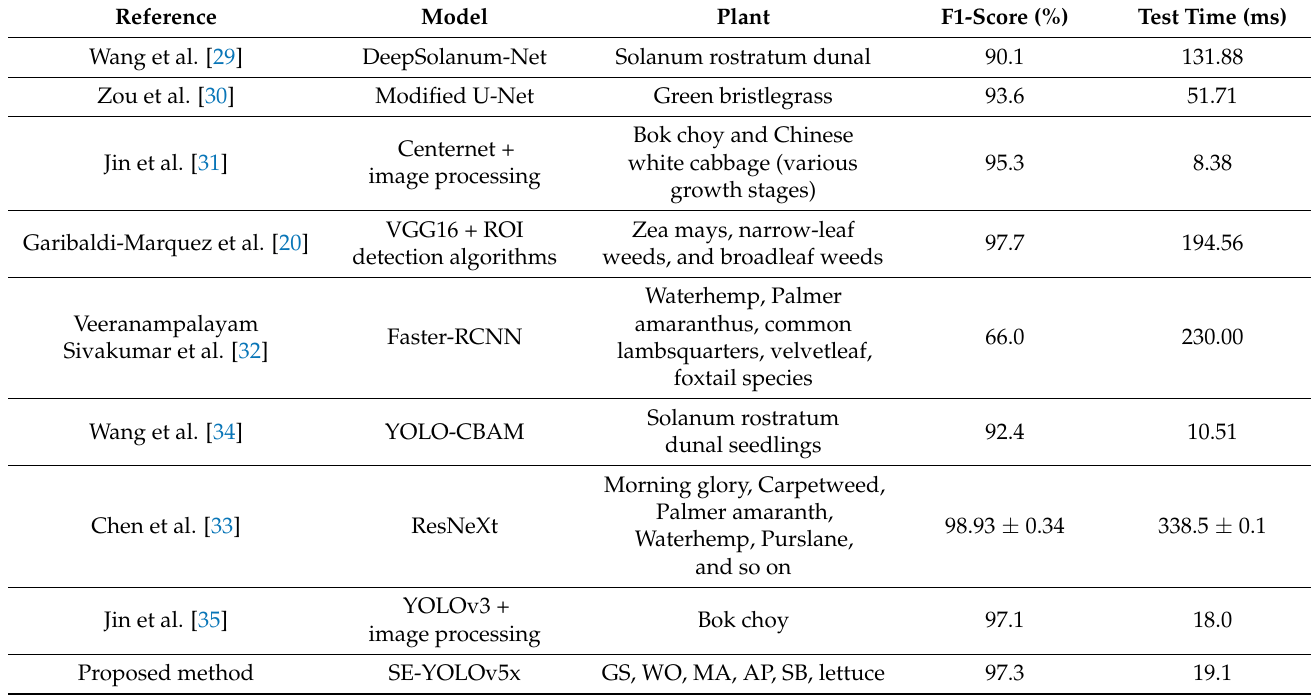
Table 5. A summary of plant identification based on different CNN